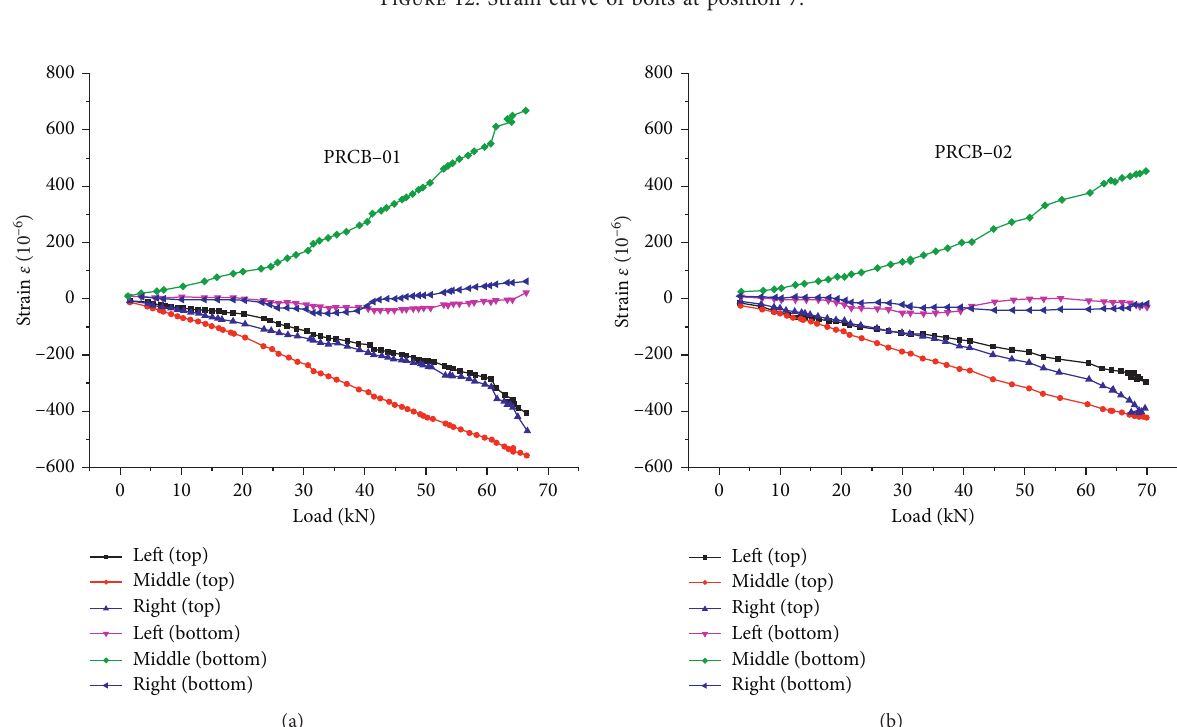
Figure 13: Load-strain curve of steel plate hoop bottom and top.